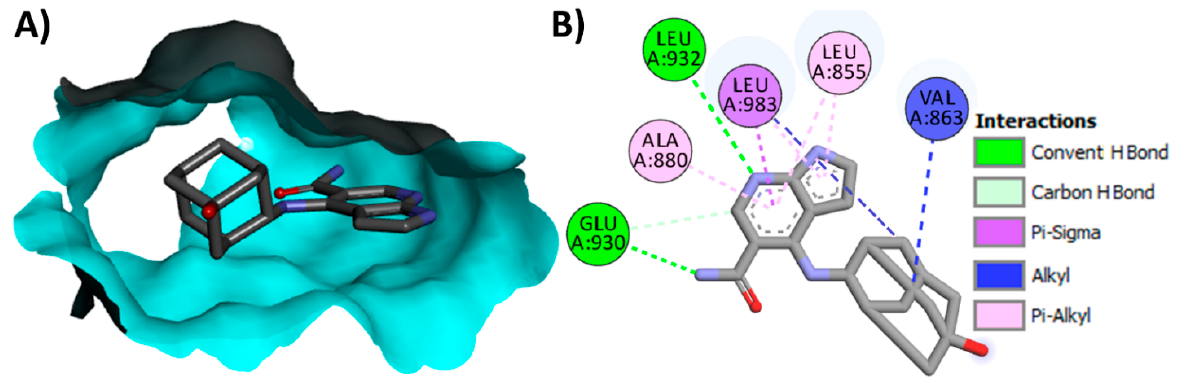
Figure 46. Binding modes of peficitinib (shown as sticks) into JAK2 (pdb: 6AAJ): ( A ) 3D binding mode, receptor shown as a hydrogen bond surface; ( B ) 2D binding mode showing different types of interactions with JAK2; hydrogen atoms were omitted for clarity; this figure was generated using Discovery Studio Visualizer (V16.1.0.15350).